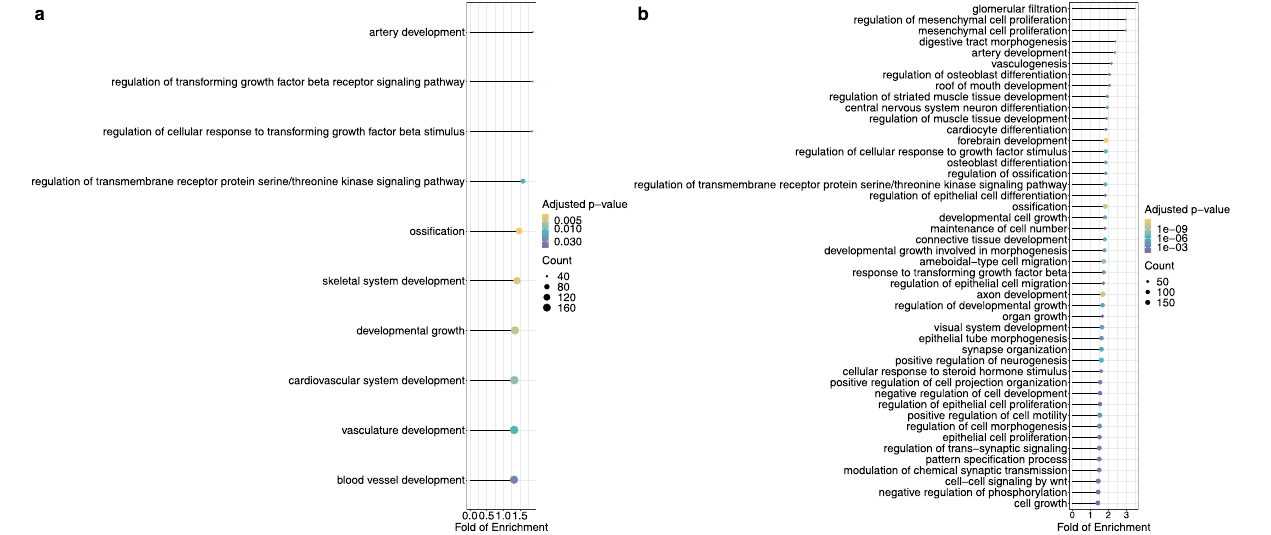
Fig. 9 | Gene ontology analysis of the genes associated with top accelerated binding sites. The dot plots show the signi fi cant GO terms after Bonferroni cor- rection for biological process of ( a ) genes associated with top accelerated binding sites of FOXP2 ( b ) genes associated with top accelerated binding sites of all seven